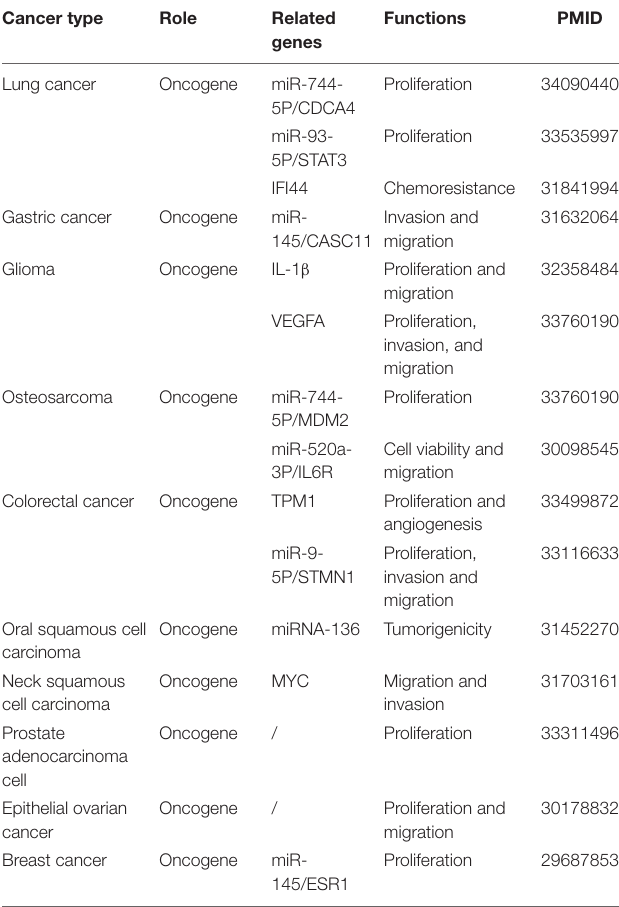
TABLE 2 | The roles and functions of LINC01116 in